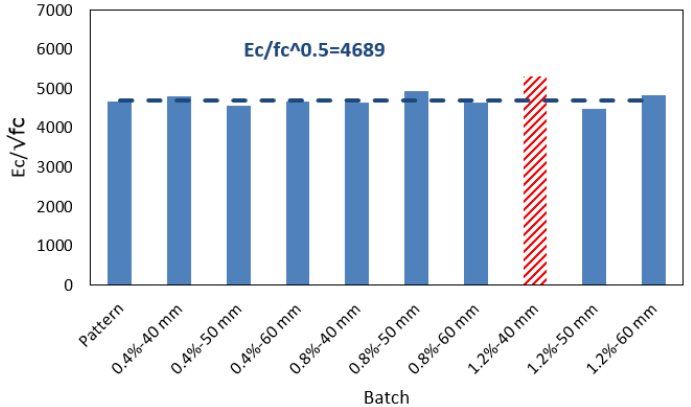
(cid:112) Figure 9. Ratio 𝐸 (cid:3030) /(cid:3493)𝑓 (cid:3030) for concrete mixtures. f c for concrete Figure 9. Ratio E c / Table 5. Compressive strength prediction equations based on UPV.